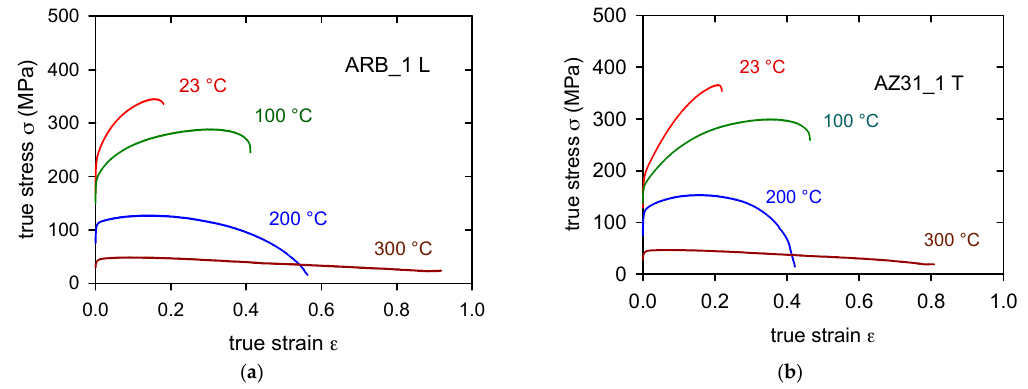
Figure 8. True stress—true strain curves obtained at various temperatures for L-samples ( a ) and T-samples ( b ) after one pass through the rolling mill.